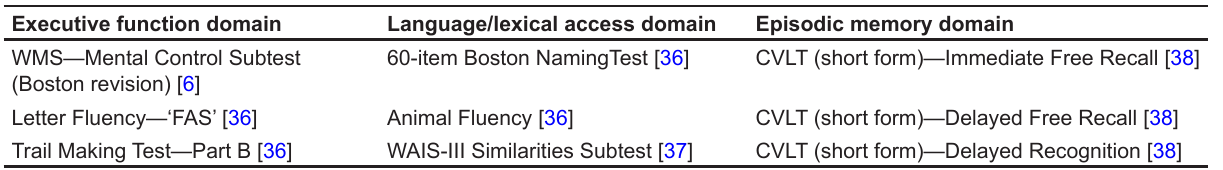
Table 1. Neuropsychological